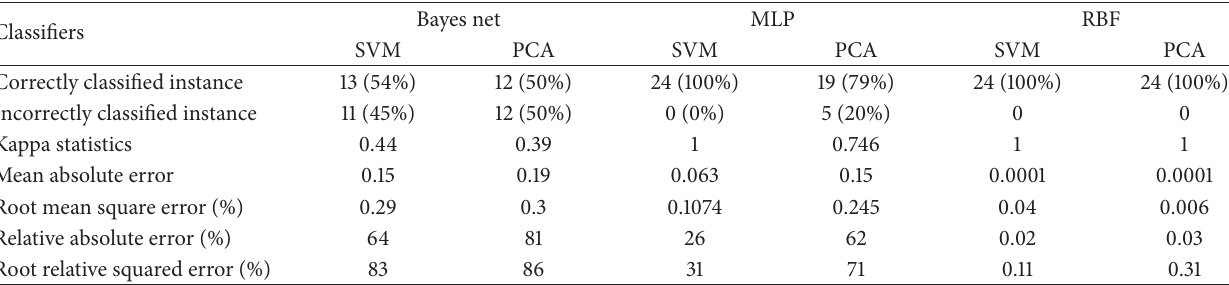
Table 11: Classifier performance comparison based on PCA and